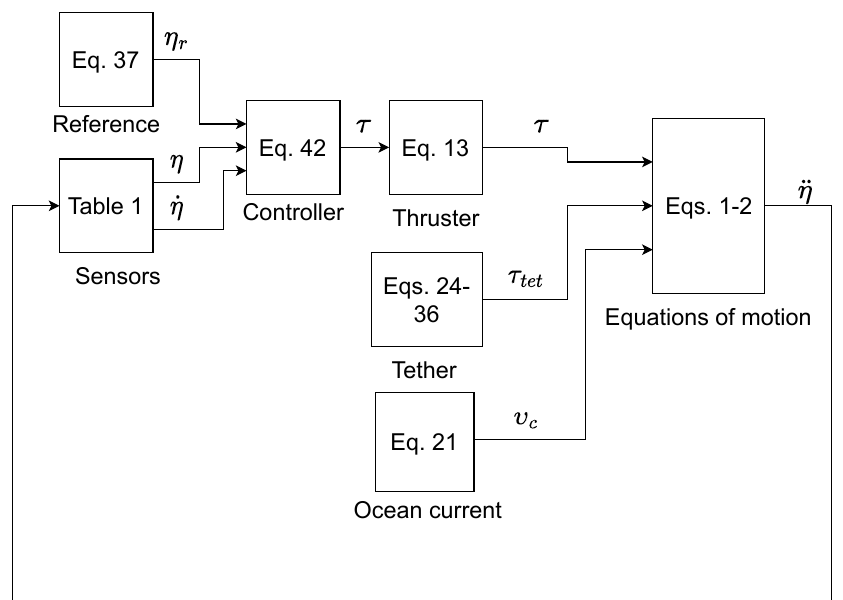
Figure 11. A simple overview of the simulator as it is implemented in